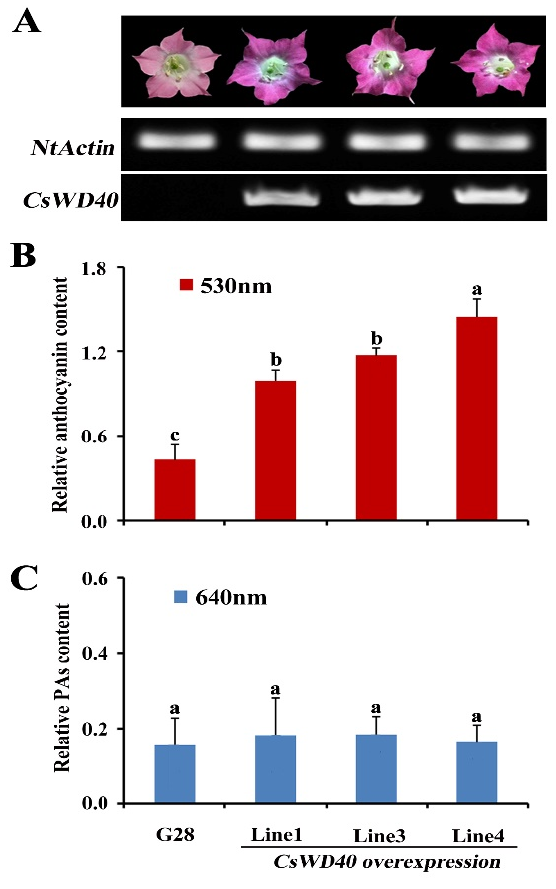
Figure 3. Identification of the CsWD40 function in transgenic tobacco. ( A ) Analysis of CsWD40 transcription levels in the flowers by semiquantitative PCR. ( B ) Relative content of anthocyanin in the flowers of CsWD40 overexpressing tobacco. ( C ) Relative soluble proanthocyanidin content in the flowers of CsWD40 overexpressing tobacco. All data are the means of three biological replicates, and the error bars represent the standard deviation of three replicates. Statistical significance was analyzed using ANOVA software (ANOVA ALL MAC VERSION 2.0, Thomas Hanson, OR, USA). Means followed by the same letter are not significantly different ( p > 0.05).